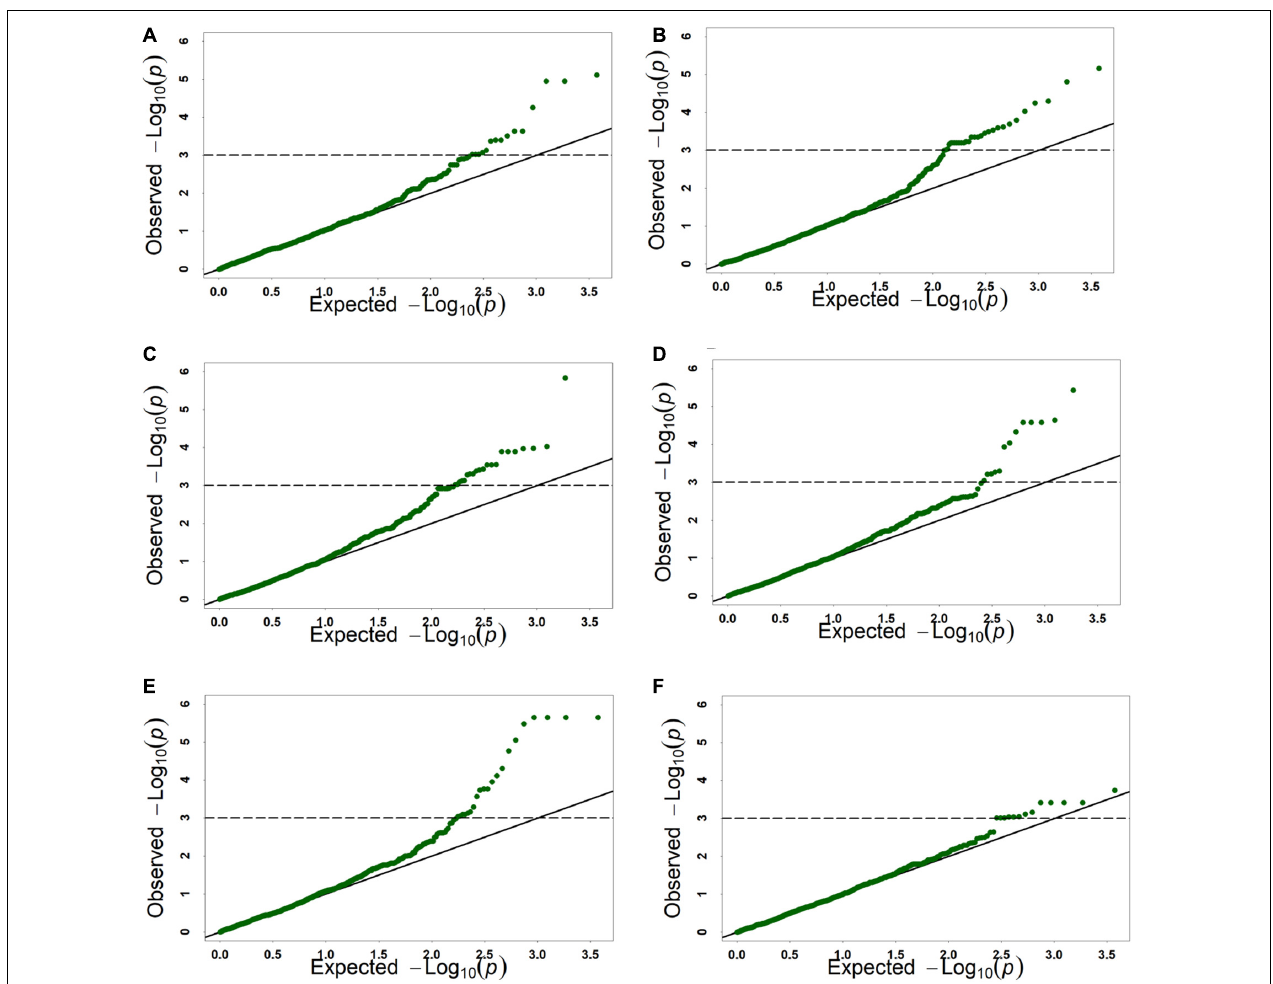
FIGURE 3 | The Q-Q plots of genome-wide association study results for six kernel traits based on BLUP value. (A) KL, kernel length, (B) KW, kernel width, (C) KV, kernel volume, (D) KSA, kernel surface area, (E) KWL, kernel width to length ratio, (F) HKW, hundred-kernel weight.